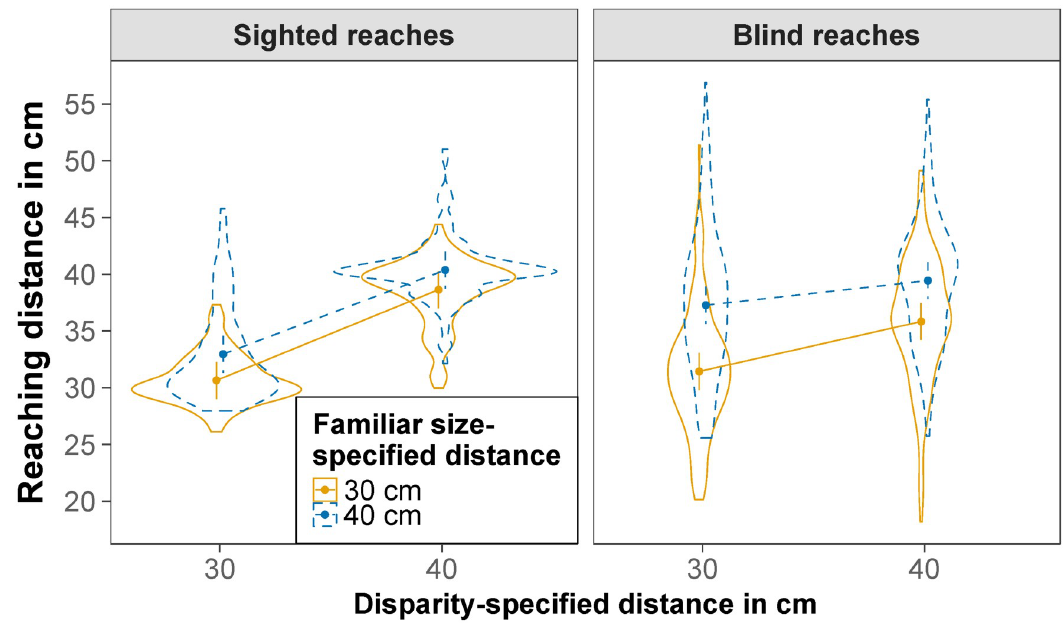
Fig 6. Reaching distance. Estimated marginal means of reaching distance for sighted reaches (left) and blind reaches (right), for a binocular disparity-specified distance of 30 cm and 40 cm and a familiar size-specified distance of 30 cm (solid orange) and 40 cm (dashed blue). Error bars are model-based 95% confidence intervals indicating which values of the estimated means are likely and do not permit comparisons across repeated-measures factors [56]. Violin plots depict the distribution of the raw data.